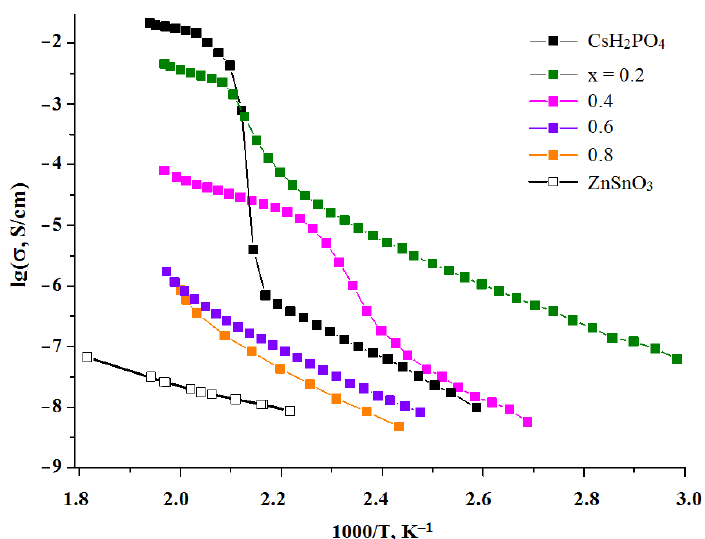
Figure 7. Temperature dependence of conductivity for composite systems (1– x )CsH 2 PO 4 – x ZnSnO 3 ( x = 0.2–0.8) in comparison with CsH 2 PO 4 and ZnSnO 3 . The conductivity measurement was carried out on two to three pellets with the same composition, but the different size. The relative error in the determining the conductivity is 2–5%.